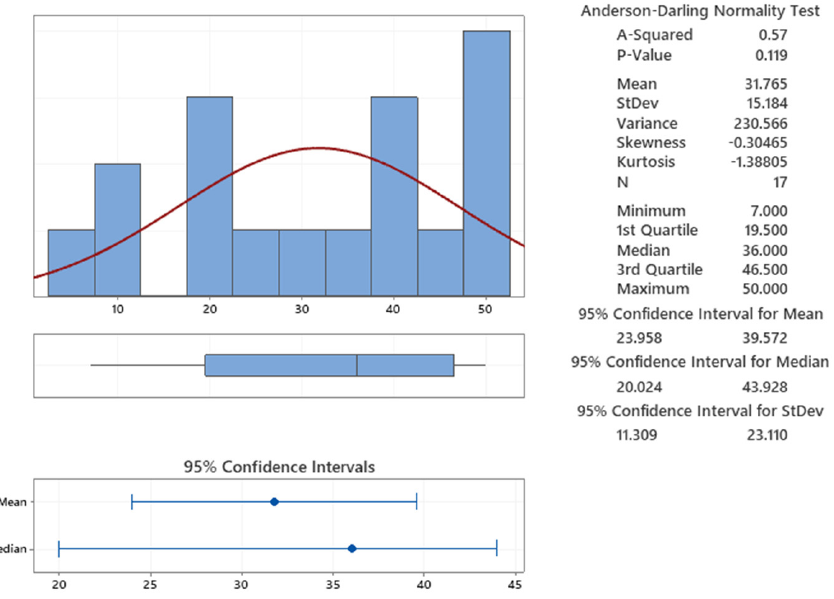
Figure 6. Average unloading time at the port.